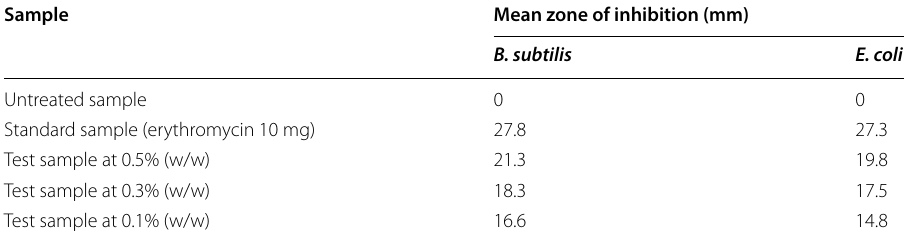
Table 4 Zone of inhibition of untreated, standard and treated sample Sample